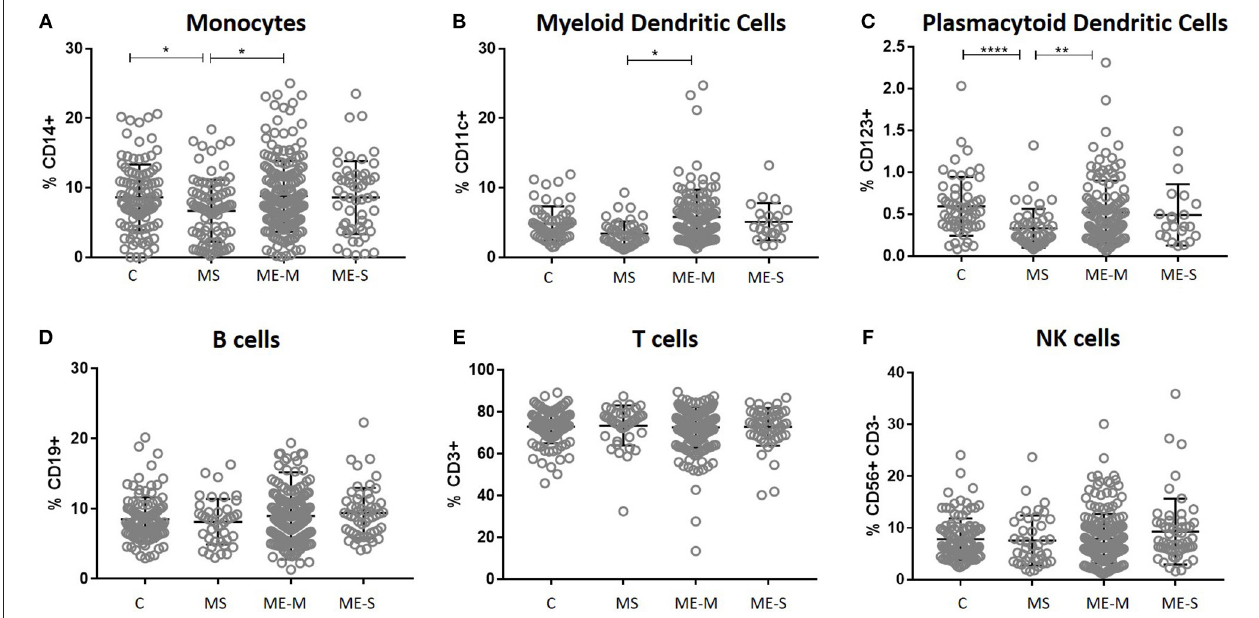
FIGURE 2 | Leucocyte populations in peripheral blood from people with ME/CFS, people with MS and healthy controls. PBMC were analysed by flow cytometry, as described in Figure 1 . The proportions of PBMC which were (A) monocytes, (B) myeloid dendritic cells, (C) plasmacytoid dendritic cells, (D) B cells, (E) T cells or (F) NK cells were calculated and shown for individual study participants. The bars show the Mean ± SD. Data are from healthy controls (C, n = 107), multiple sclerosis (MS: n = 46), mild/moderate ME/CFS (ME-M: n = 197), and severely affected ME/CFS (ME-S: n = 54) for (A,D–F) and from C ( n = 56), MS ( n = 46), ME-M ( n = 120), and ME-S ( n = 21) for (B,C) . Clinical groups were compared by Kruskal-Wallis test for non-parametric data: * P < 0.05, ** P < 0.01, **** P <